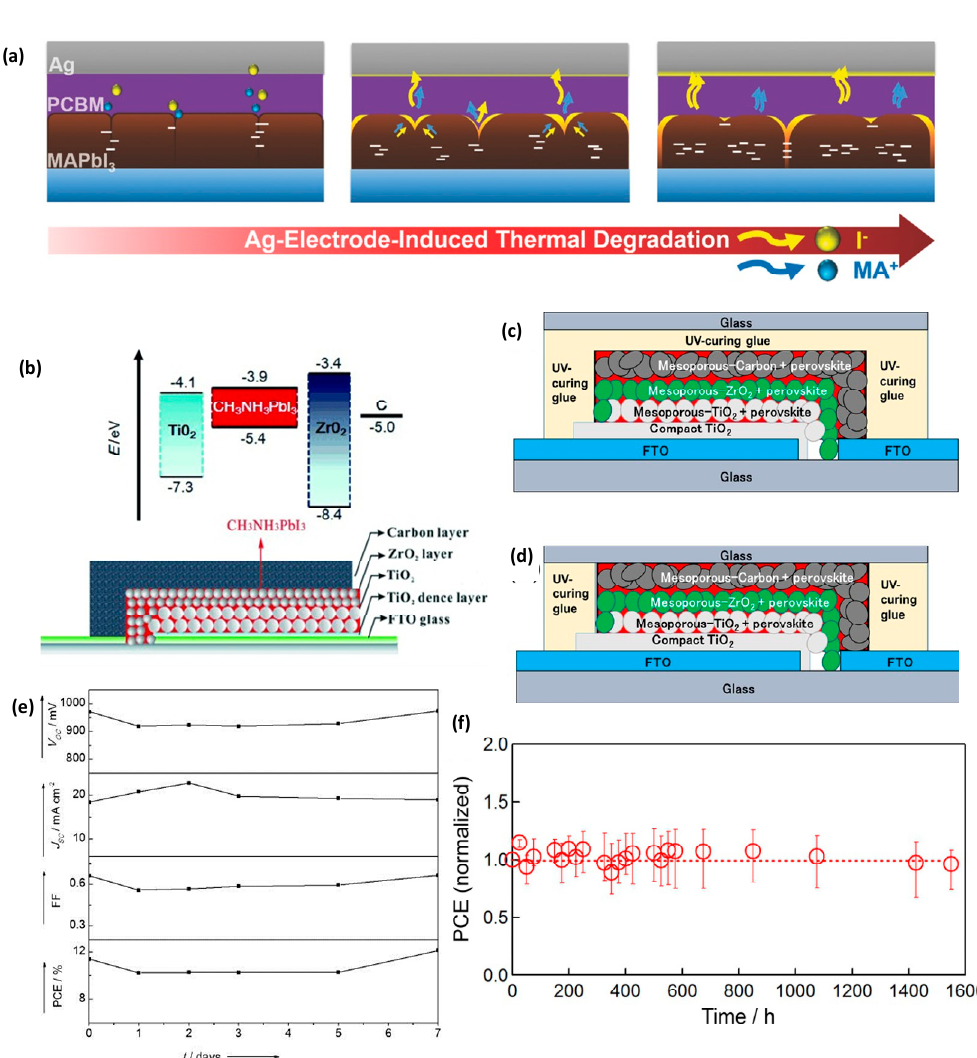
Figure 10. ( a ) A proposed mechanism for Ag-electrode-induced thermal degradation of the inverted perovskite solar cells (PSCs). Reprinted from [71], with permission. ( b ) A schematic of fabricated perovskite solar cells (PSCs) with carbon electrodes and ( c ) Photovoltaic parameters of the encapsulated perovskite solar cell plotted versus time during outdoor aging in Jeddah, Saudi Arabia. Reprinted from [16], with permission. Diagram of a three-layer perovskite device: ( d ) over-sealed and ( e ) side-sealed cell. ( f ) photo-conversion efficiency (PCE) of PSCs fabricated using the side-sealing configuration during thermal stability testing at different temperatures in the dark. Reprinted from [73], with